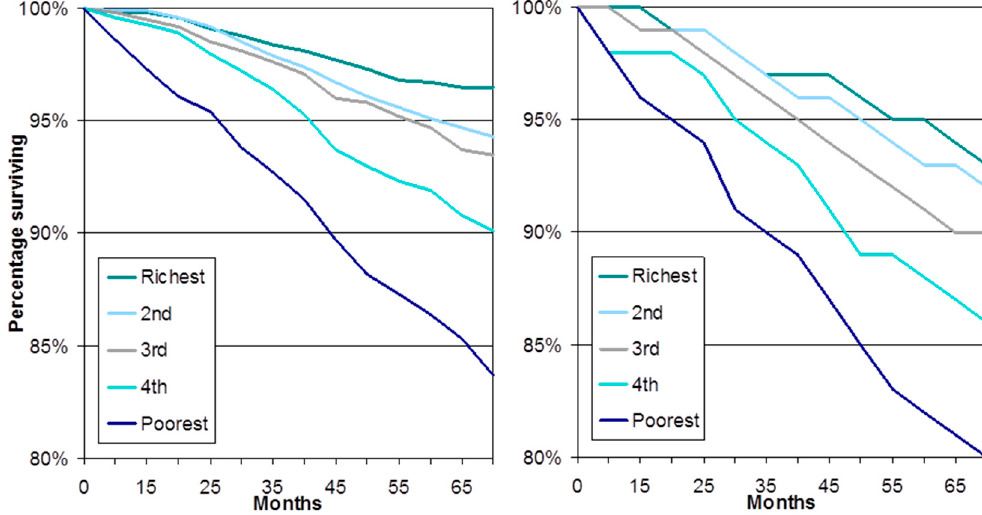
Figure 1. Survival rates stratified by wealth quintile: women and men aged 50 or older .